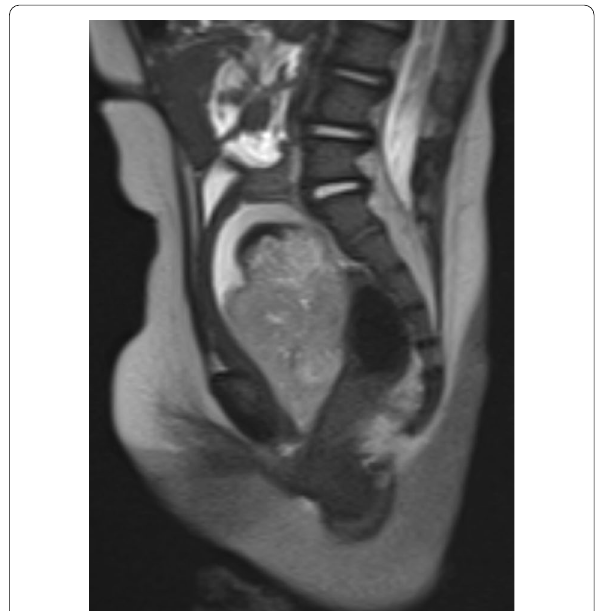
Fig. 1 T2 sagittal image of the tumor at diagnosis. Magnetic resonance image shows a large solid mass in the